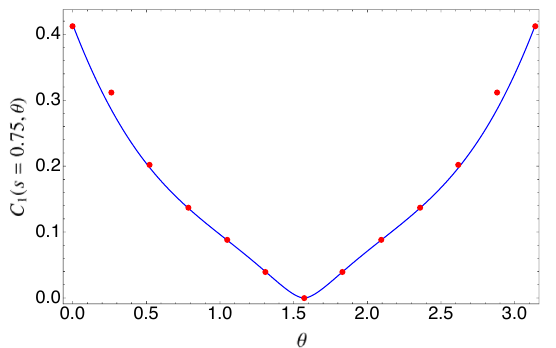
Figure 3 . The coefficient of the logarithmic term of the negativity between two wires ( A and B ) as a function of θ , with fixed s = 0 . 75 . The solid line corresponds to eq. (3.20) while the points have been obtained through a fit of the numerics with the form a log N + b